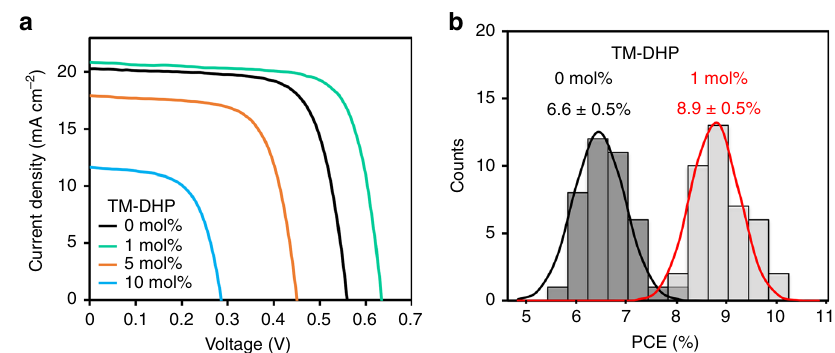
Fig. 4 Performance of the Sn-based perovskite solar cell devices. a J – V curves of Sn-based PSCs with device area of 0.1 cm 2 , prepared by adding 0, 1, 5, and 10 mol% of reductant TM-DHP, respectively, under AM1.5 G, 100 mW cm – 2 irradiation. b Statistics of the PCE distribution of 40 cells with and without 1 mol% of TM-DHP.